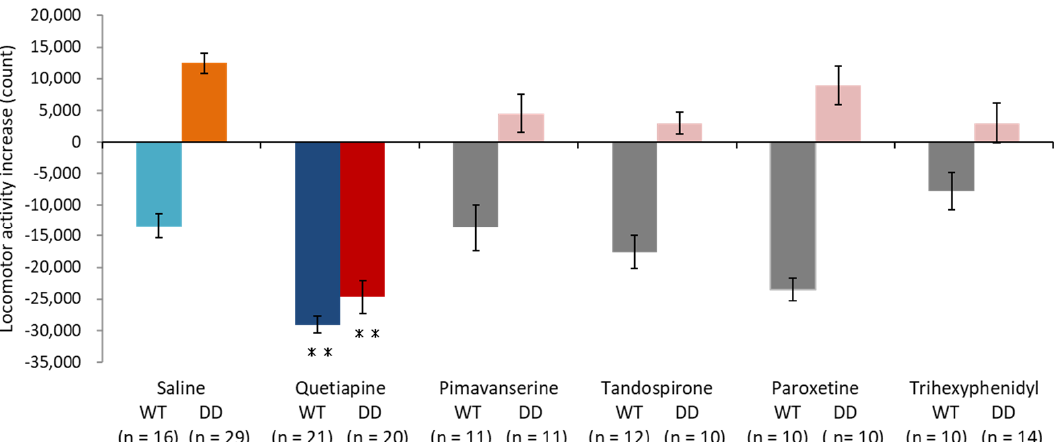
Figure 1. Behavioral changes related to PSDD induced by drug administration. Total locomotor activity increased (3 h after drug administration—3 h before drug administration). ** p < 0.01, compared with saline administration (Scheffé test). The graph shows the number of animals per group. The data are expressed as mean ± SEM. WT, wildtype mice; DD, dopamine-deficient mice.